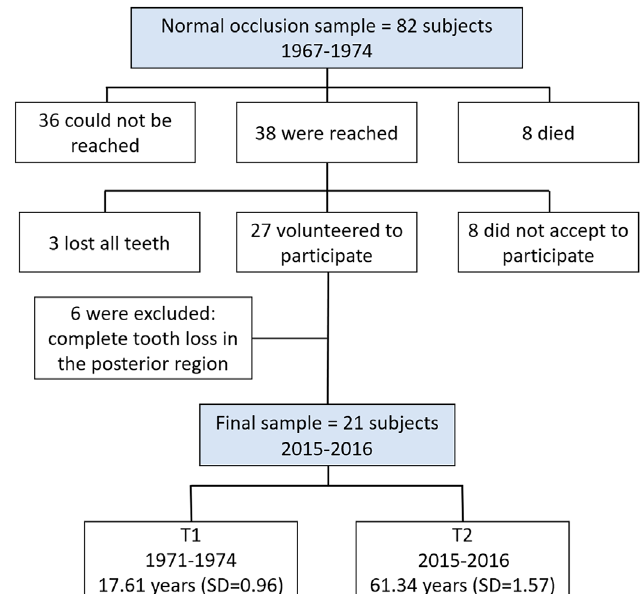
Figure 1- The enrollment process and age distribution during the 40-year follow-up